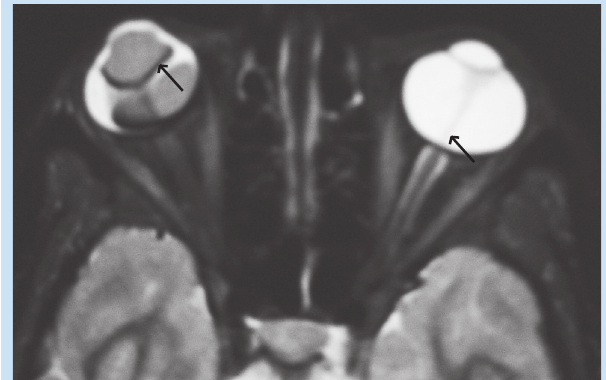
Fig. 1. Axial T2-weighted image demonstrates bilateral anterior and poste- rior PHPV. Left eye: (Posterior PHPV) most of the globe content gives a very high signal that could be due to intraocular haemorrhage accompanying retinal detachment. Note canal of Cloquet (hyaloid canal) connecting the optic disc to the lens. Right eye: the displaced retina appears as a thin black line (arrow). The low signal represents subretinal haematoma that extends to the anterior